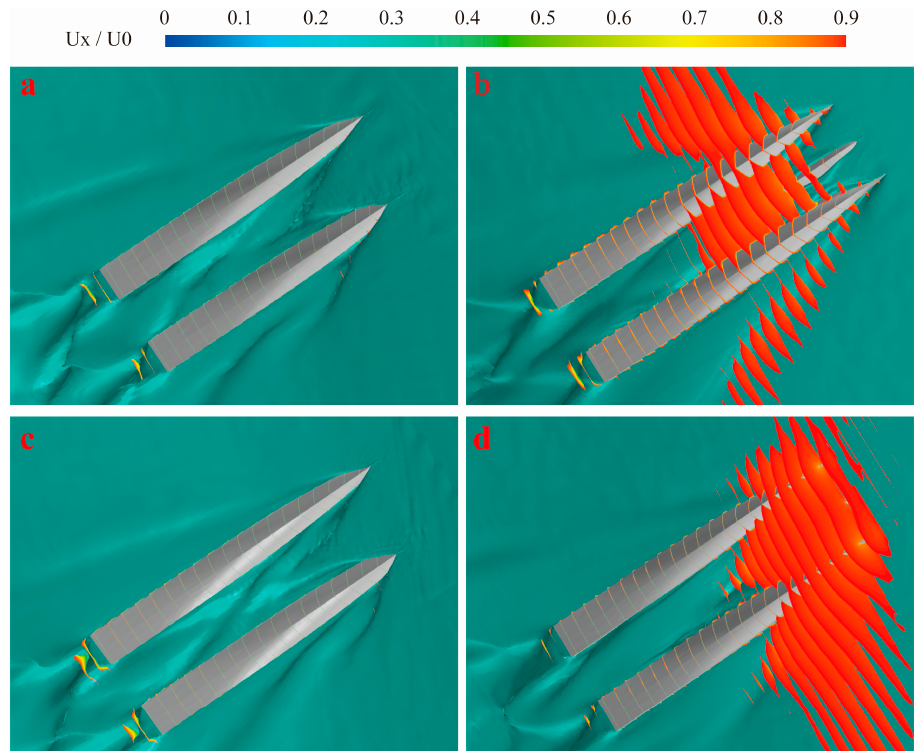
Figure 30. Boundary layer represented by slices colored with dimensionless axial velocity limited to U x /U 0 = 0.9 at 5 level sea state with the 30° wave direction. ( a ) T = 1/4 T 0; ( b ) T = 2/4 T 0; ( c ) T = 3/4 T 0; ( d ) T = 4/4 T 0.